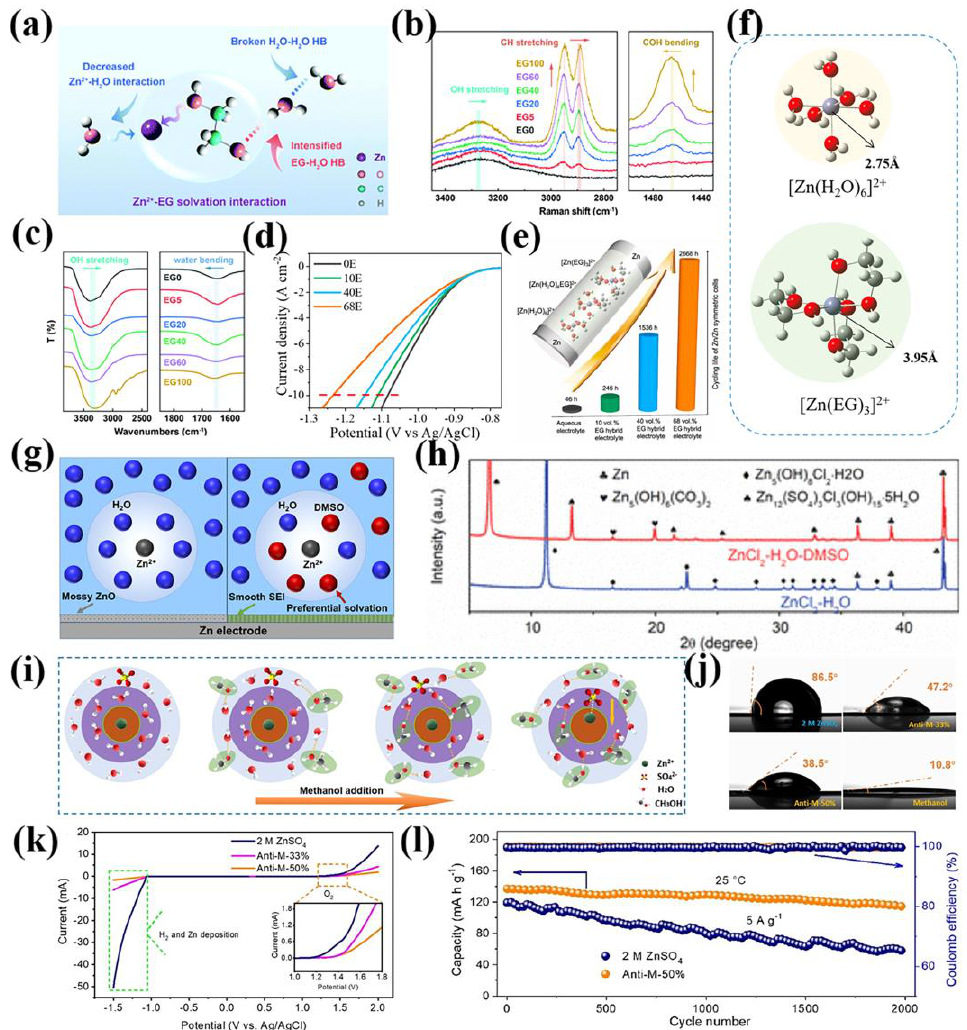
Figure 7. ( a ) Schematic illustration of a possible mechanism of how Zn 2+ -EG solvation interaction impacts the chemistry of the hybrid electrolyte. ( b ) Raman spectra of a series of hybrid electrolytes. ( c ) FTIR spectrum of the hybrid electrolytes. Adapted with permission from Ref. [72]. Copyright 2020 Energy & Environmental Science. ( d ) HER curves in different electrolytes. ( e ) Schematic illustration of coordination state of Zn 2+ in H 2 O/EG hybrid electrolytes, and the effect of EG on the cycling stability of Zn||Zn symmetric cells. ( f ) Coordination complexes of Zn[(H 2 O) 6 ] 2+ and Zn[(EG) 3 ] 2+ . Adapted with permission from Ref. [75]. Copyright 2021 Nano Energy. (g) Scheme of Zn 2+ solvation structure and zinc surface passivation in H 2 O (left) and H 2 O − DMSO (right) solvents. ( h ) XRD patterns of Zn anodes after plating/stripping cycles in ZnCl 2 – H 2 O – DMSO and ZnCl 2 – H 2 O electrolytes. Adapted with permission from Ref. [78]. Copyright 2020 American Chemical Society. ( i ) Schematic of changes in the Zn 2+ solvent sheath with methanol addition. ( j ) Contact angle measurement on Zn electrode. (k) LSV response curves for different electrolytes at 0.1 mV s −1 . ( l ) Cycling stability of Zn||PANI coin cells at 5 A g −1 with different electrolytes. Adapted with permission from Ref. [81]. Copyright 2021 Angewandte Chemie International Edition.